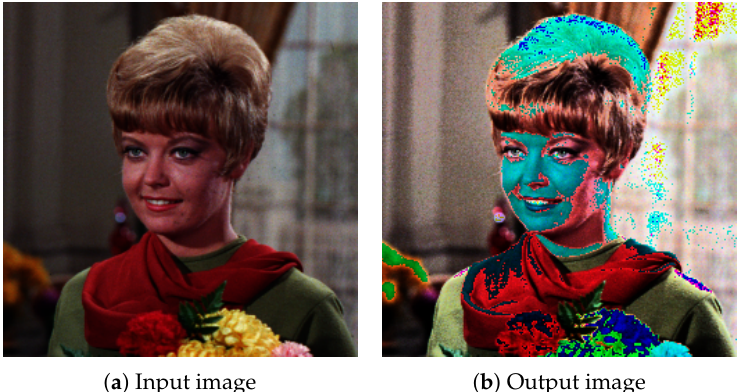
Figure 2. Color image enhancement by histogram equalization with the gamut problem. The intensity histogram of an input color image ( a ) is equalized, and the corresponding colors in the output image ( b ) are computed by (7). The computed color values are saved with the ‘Image.save’ function in Python Image Library (PIL).